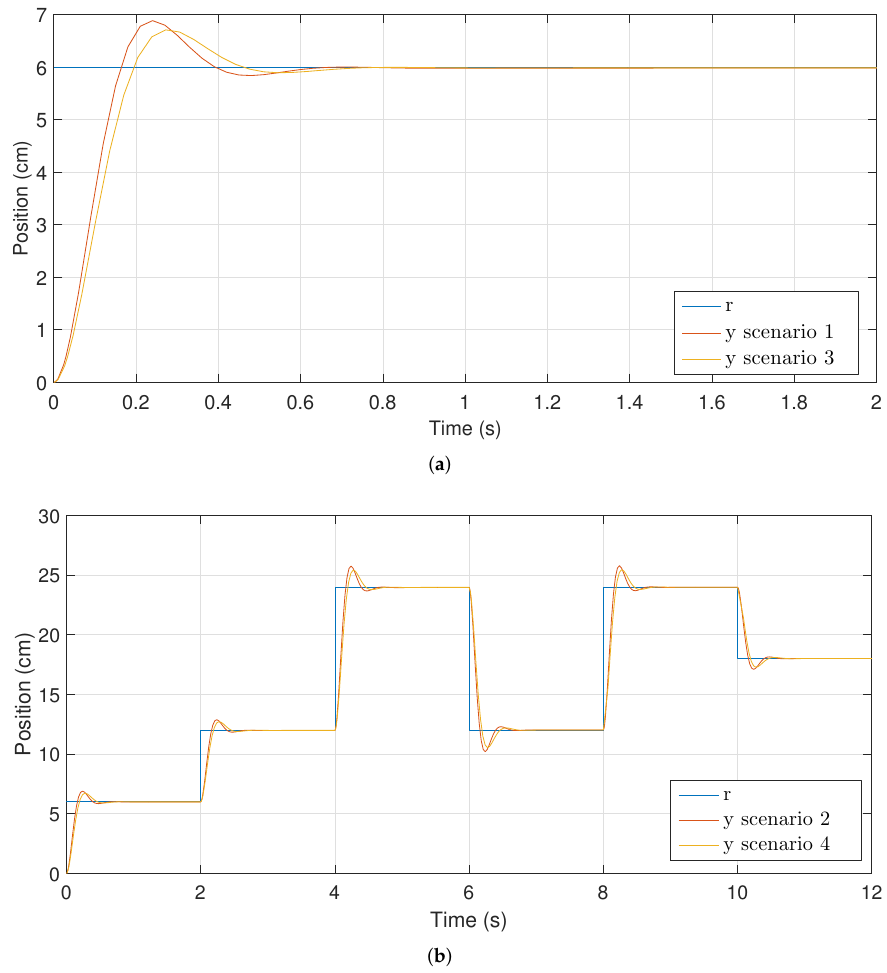
Figure 8. Controller behavior implemented in the experimentation platform. ( a ) Results for scenario 1 and 3; ( b ) results for scenario 2 and